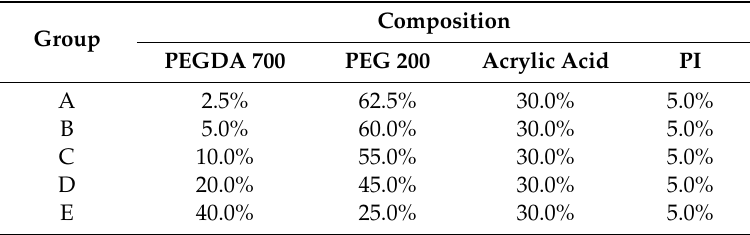
Table 1. Prepolymer composition of the five tested groups.